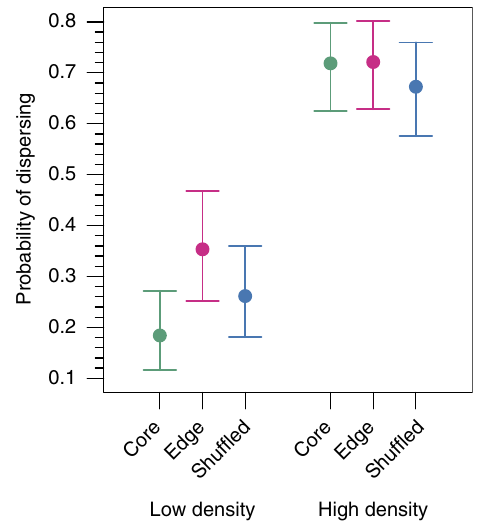
Figure 2 | Evolved density dependence of dispersal probability. Mean probability of beetles dispersing out of their patch of origin with low and high initial densities (10 and 40 adult beetles). Results for G1 descendants from the core ( n ¼ 28) and edge ( n ¼ 28) of structured landscapes and G1 descendants from shuffled landscapes ( n ¼ 58) are shown. Filled circles are model estimates from a binomial generalized linear mixed effects model with a logit link function. Error bars are bootstrapped 95% confidence intervals. Core populations are shown in green, edge populations in fuchsia and shuffled populations in blue. Spatial evolution led to a higher proportion of beetles dispersing from edge populations at low density (parametric bootstrap, interaction of density and location: P ¼ 0.0008).